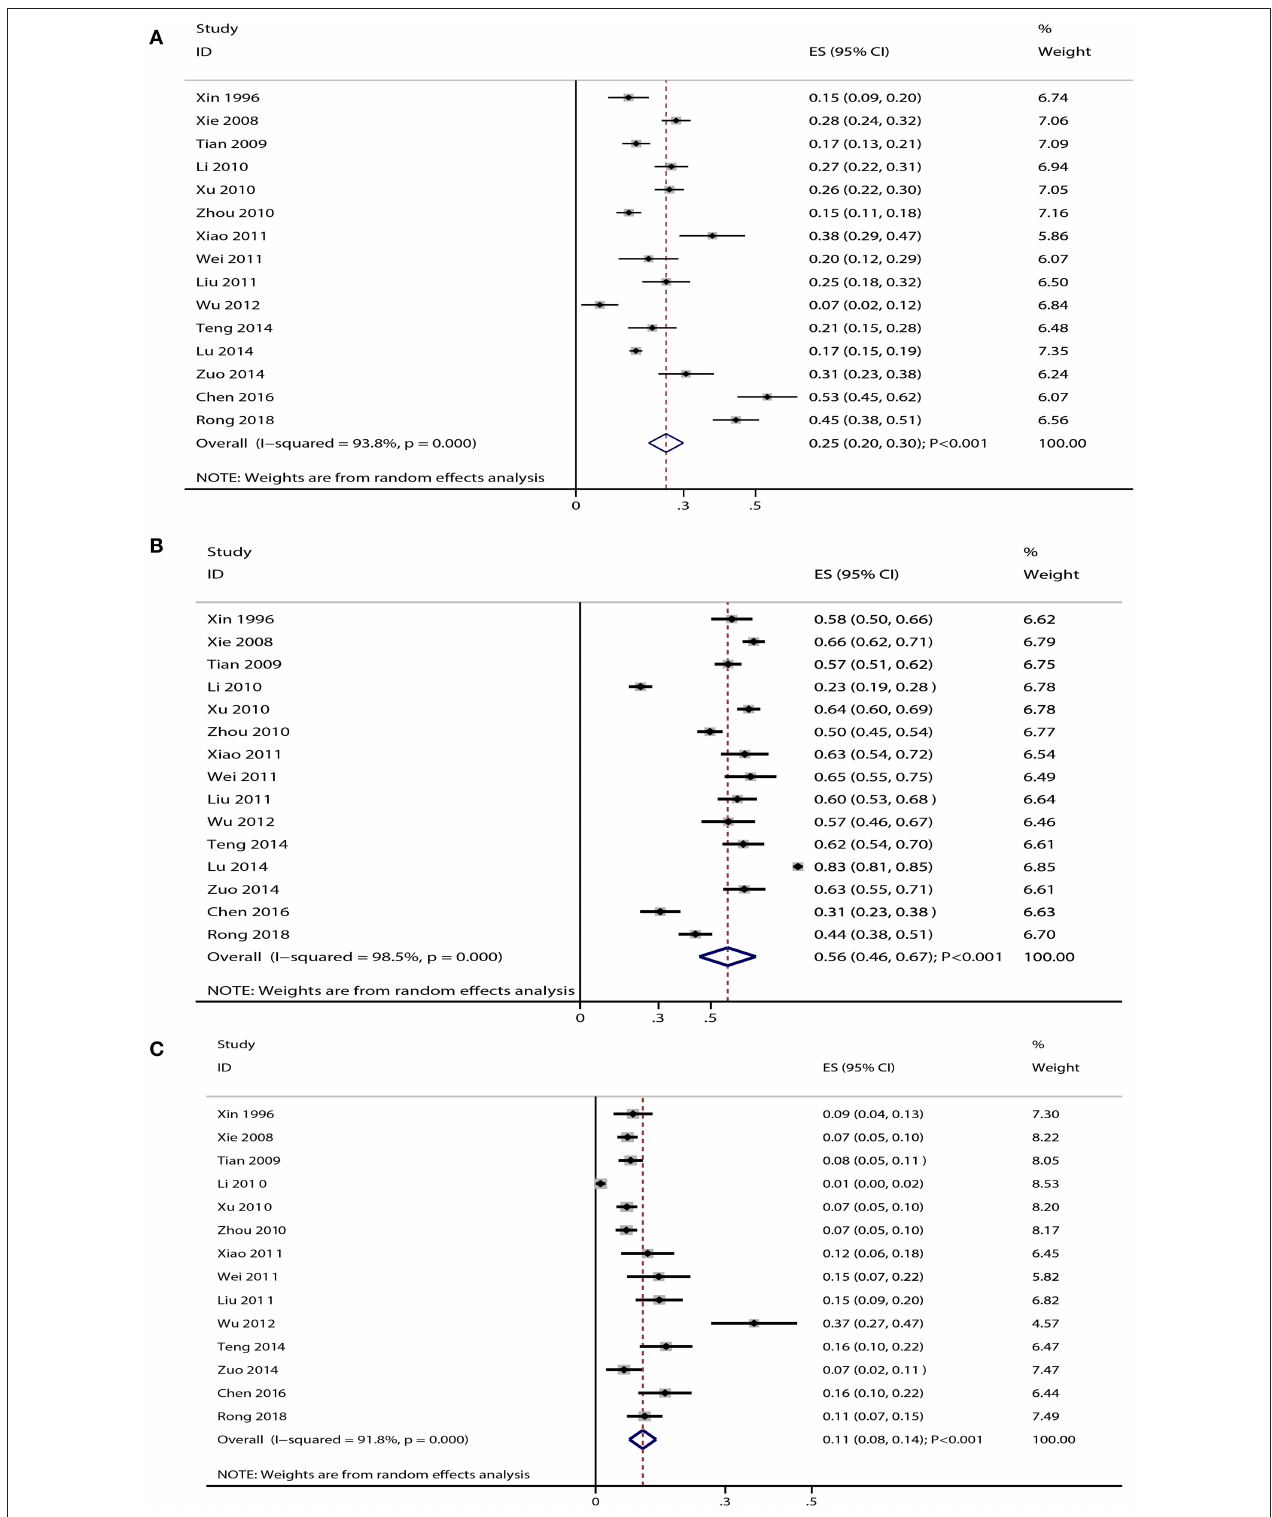
FIGURE 1 | (A) Summary prevalence for gram-positive cocci in elderly patients with pneumonia. (B) Summary prevalence for gram-negative bacilli in elderly patients with pneumonia. (C) Summary prevalence for fungus in elderly patients with pneumonia.